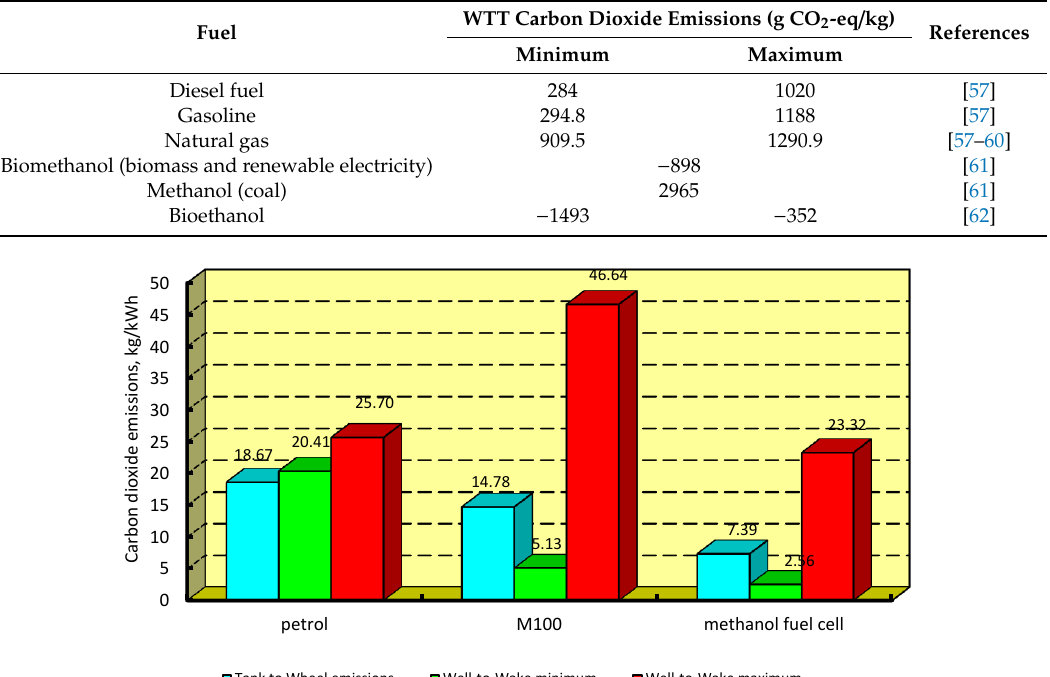
Table 2. Well-to-tank (WTT) carbon dioxide emissions for selected fuels.